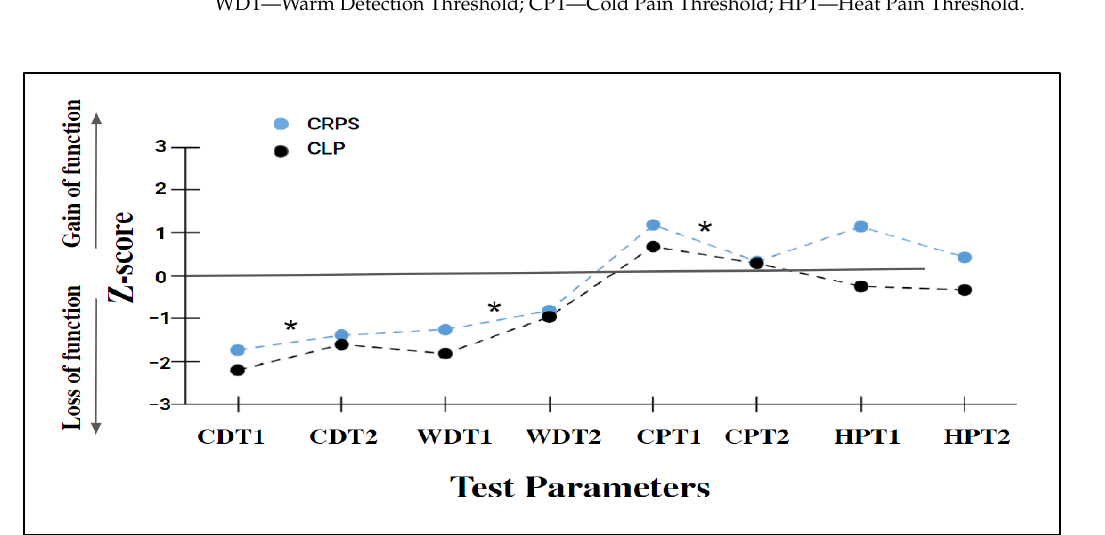
Table 2. The differences in thermal and pain threshold between limbs in CRPS and CLP groups.